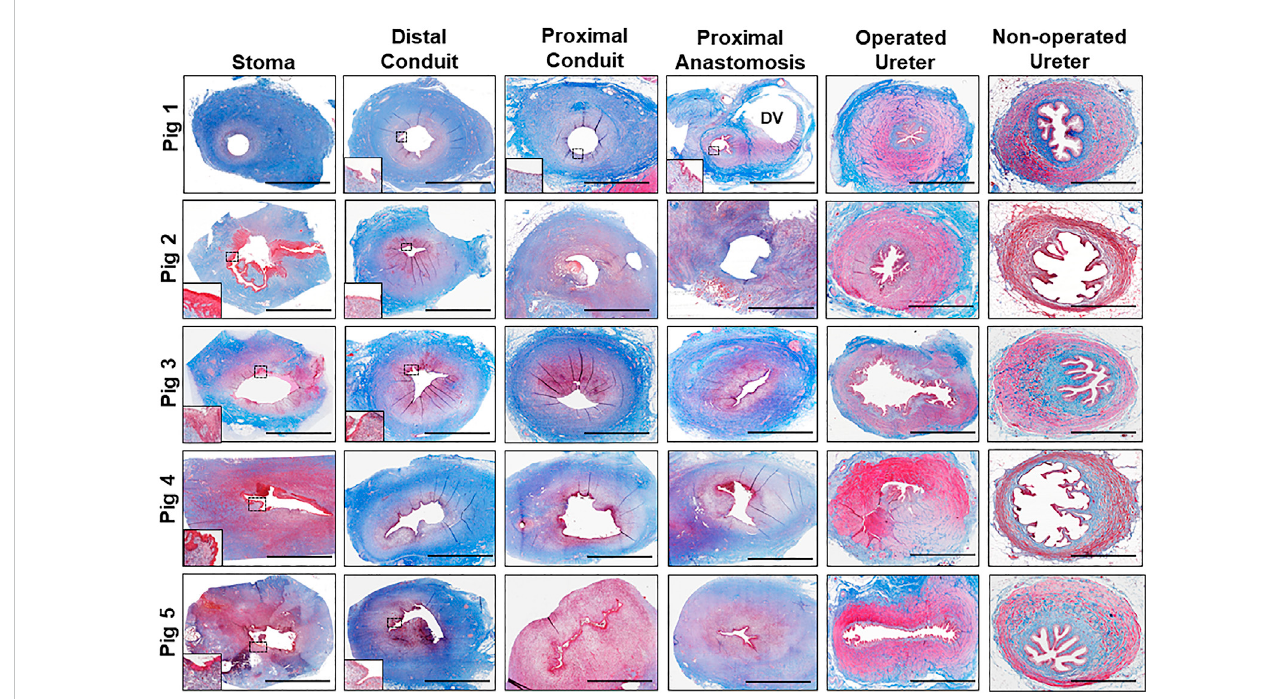
FIGURE 4 Histological evaluationsoftissue regeneration inneoconduits.Photomicrographsofneoconduitcross-sectionsalongtheaxiallength (stoma, proximal/ distal conduit, proximal anastomosis) as well as control tissues (operated and non-operated ureters) from Pigs one to fi ve stained with Masson ’ s trichrome. Boxed regions denote regions of de novo epithelialization with insets presenting magni fi ed views of neoepithelia. DV denotes diverticula formation in Pig 1. Scale bars for all panels = 1